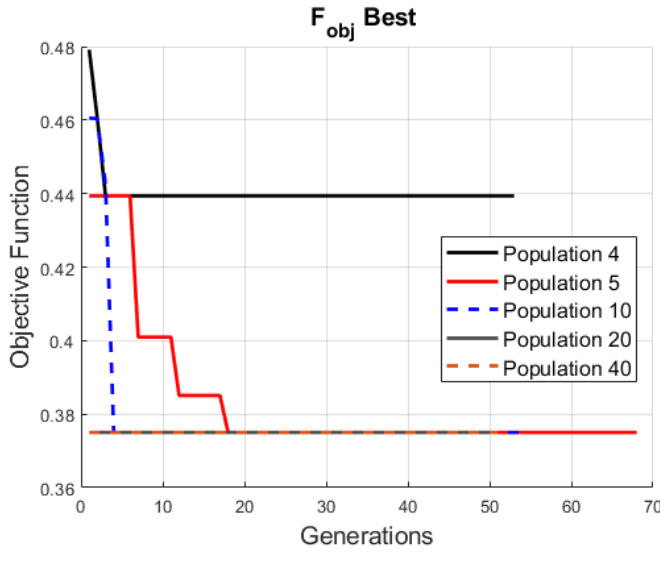
Figure 6. Population sensibility.